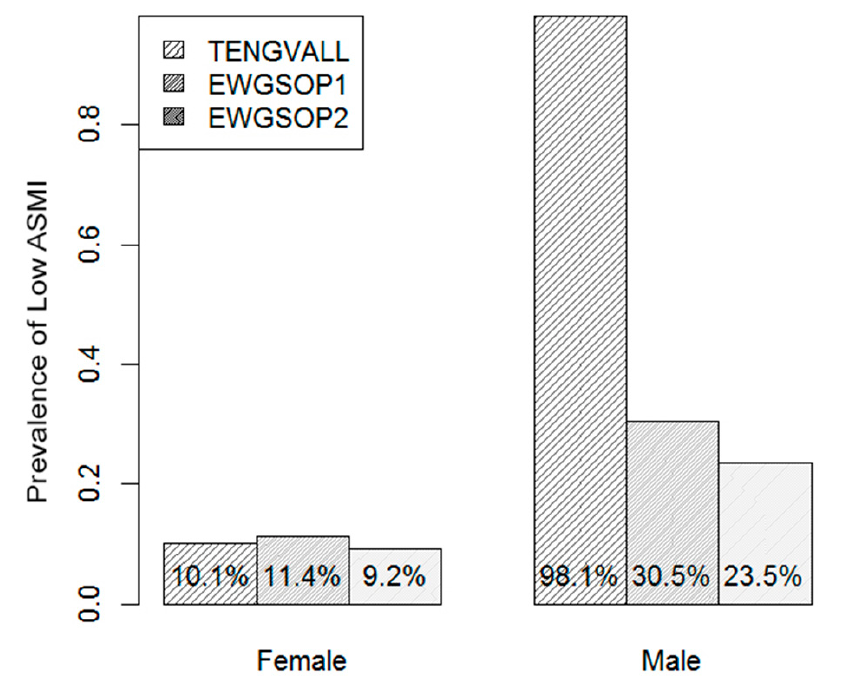
Figure 2. The prevalence of low ASMI (muscle loss) under each diagnostic criterion and calculated per gender.